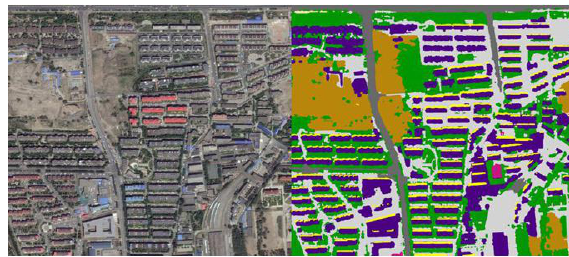
Fig.6 Features Extraction Based on Machine Learning (c) Automatic extraction algorithm for inconsistent